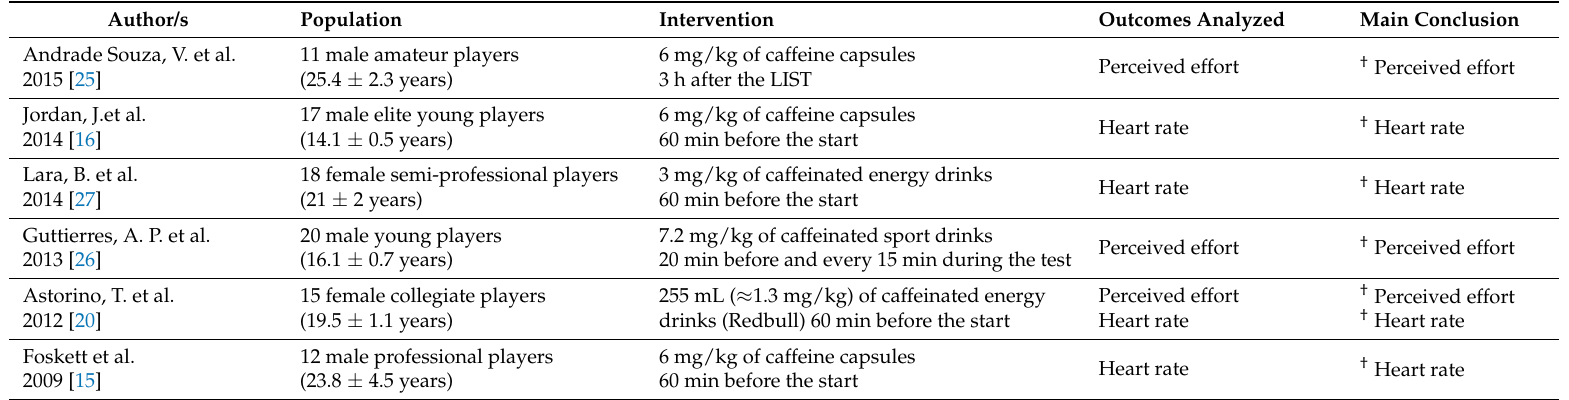
Table 3. Summary of studies included in the systematic review that investigated the effect of caffeine ingestion as compared to a placebo on perceived fatigue and heart